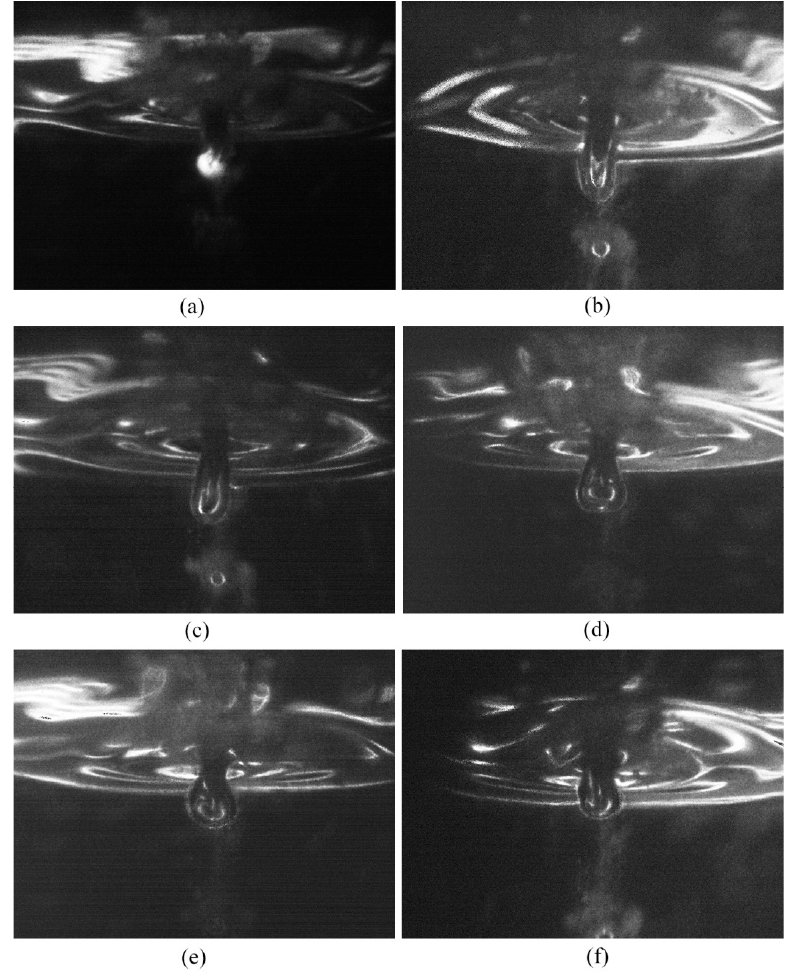
Figure 9. Effects of type − 3 discharge on gas film. ( a ) 0 µ s, ( b ) 100 µ s, ( c ) 200 µ s, ( d ) 300 µ s, ( e ) 400 µ s, ( f ) 500 µ s.